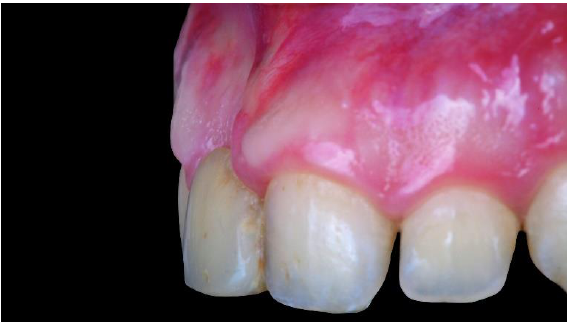
Figure1. deficiency.